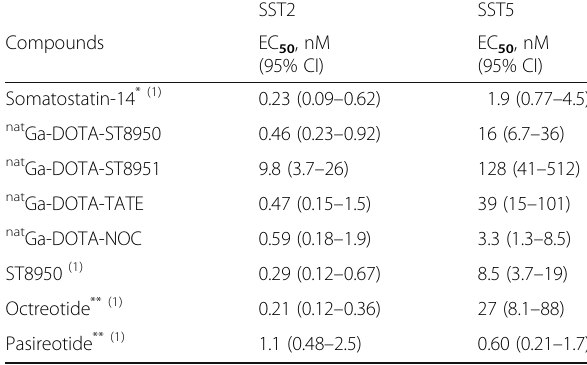
Table 3 Agonistic potency toward SST2 and SST5 of all four nat Ga-DOTA-conjugates compared to reference somatostatin analogs